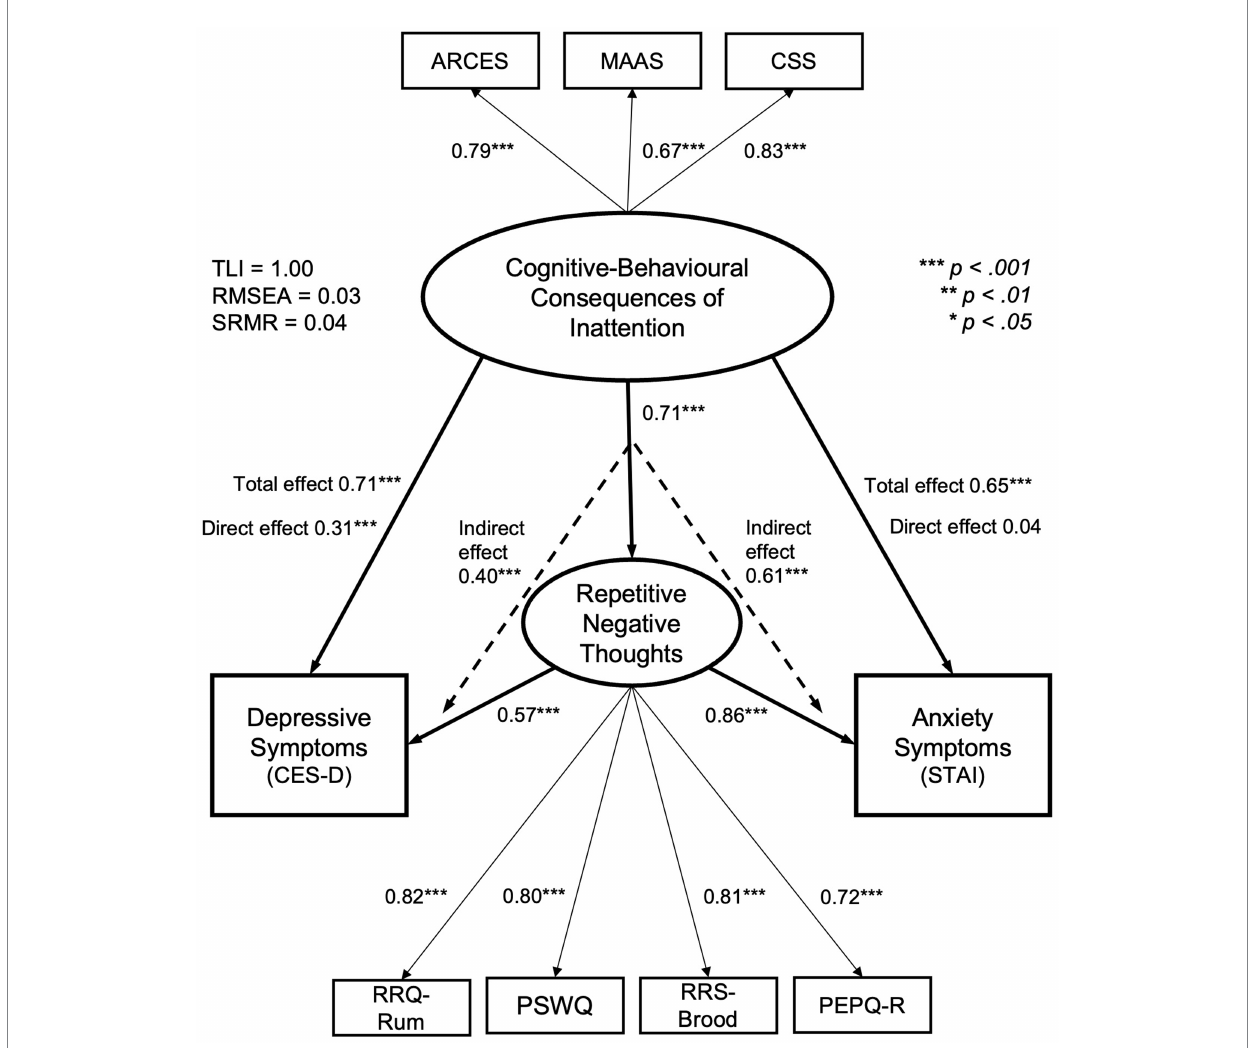
FIGURE 1 SEM model representing repetitive negative thoughts as a mediator in the relationship between cognitive-behavioral consequences of inattention and depressive/anxiety symptoms. N = 612. * p < 0.05, ** p < 0.01, *** p < 0.001. Partial mediation of Repetitive Negative Thoughts (RNTs) was supported for consequences of inattention effect on depressive symptoms, and full mediation of RNTs was supported for consequences of inattention effect on anxiety symptoms. Standardized ß s are reported. ARCES, Attention-Related Cognitive Errors Scale; MAAS, Mindful Attention and Awareness Scale; CSS, Current Symptoms Scale; CES-D, Center for Epidemiologic Studies Depression Scale; STAI, State–Trait Anxiety Inventory; RRQ-Rum, Rumination- Reflection Questionnaire Rumination Subscale; PSWQ, Penn State Worry Questionnaire; RRS-Brood, Rumination Responses Scale Brooding Subscale; PEPQ-R, Post-Event Processing